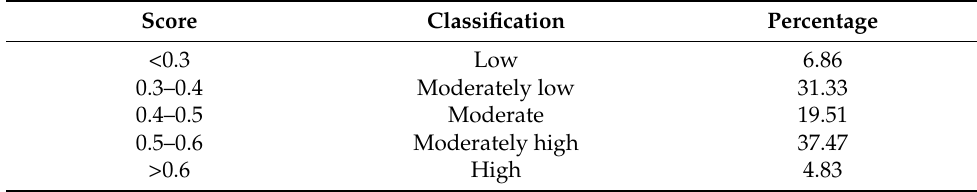
Table 6. LWLCI classification and percentage of area covered.